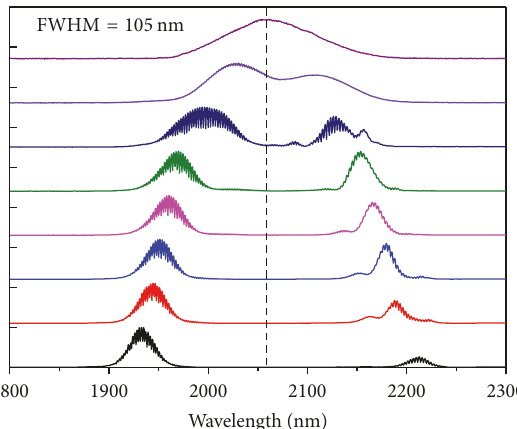
Figure 3: Spectra evolution from the near-degenerate operation to the degeneracy of the OPO. Dash line: the degenerate point.